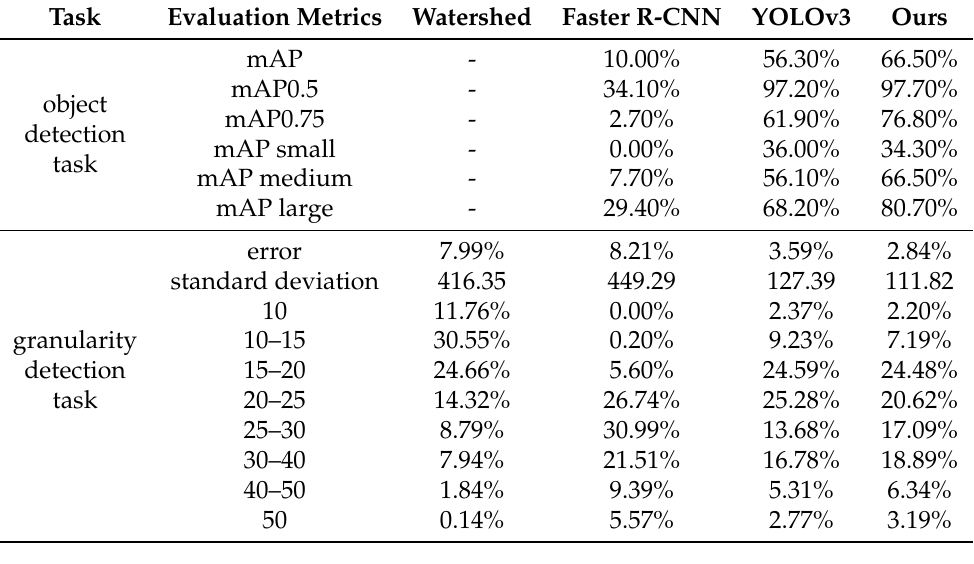
Table 5. Comparative experiments performed on the clay validation set in CCD.